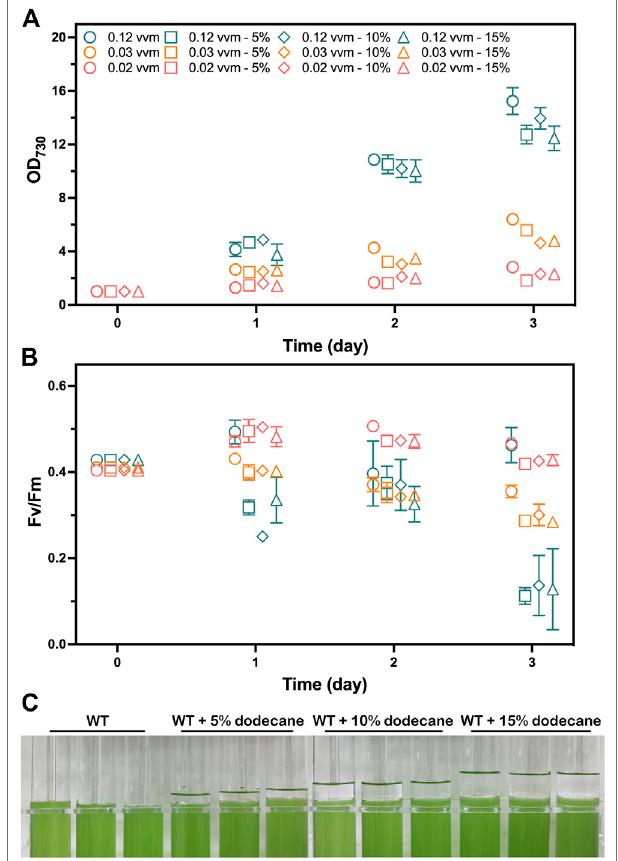
FIGURE 2 | Photoautotrophic performance analysis of the WT strain grown with 1% ( v / v ) CO 2 aeration at 0.12, 0.03, and 0.02 vvm for 3 days. The mediums were overlaid with 0%, 5%, 10%, and 15% ( v / v ) of dodecane, respectively. Samples were collected for the analysis at 1-day intervals. (A) The photoautotrophic growth parameters monitored by OD 730 . (B) Photosyntheticef fi ciencyevaluatedbychlorophyll fl uorescenceparameterFv/ Fm. The works on the WT strain grown with 0%, 5%, 10%, and 15% ( v / v ) of dodecane overlay are shown as circles, squares, diamonds, and triangles, respectively. The works on the WT strain grown with 1% ( v / v ) CO 2 aeration at 0.12, 0.03, and 0.02 vvm are shown as teal, tangerine, and salmon colors, respectively. (C) ImageoftheWTstraincultivatedinA+medium with0%,5%, 10%, and 15% ( v / v ) of dedocane overlay, respectively. The error bars represent standard deviations of means (mean ± SD, n (cid:2)